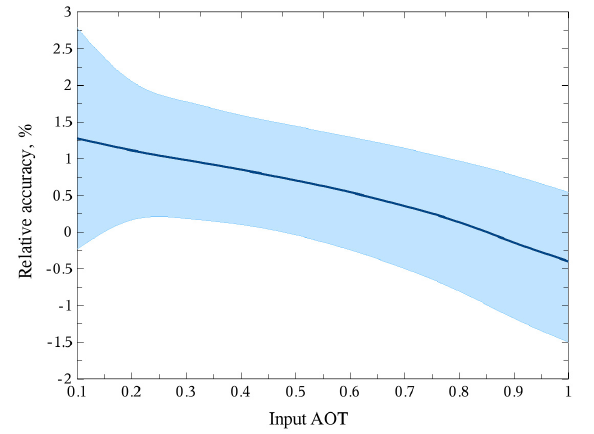
Fig. 7. The phase function of Arctic haze measured on 23 March 2000 during one of the regular haze events at Spitsbergen, Ny ˚Alesund, Svalbard, 78.923 ◦ N 11.923 ◦ E, by the Alfred Wegener Institute for Polar and Marine Research at